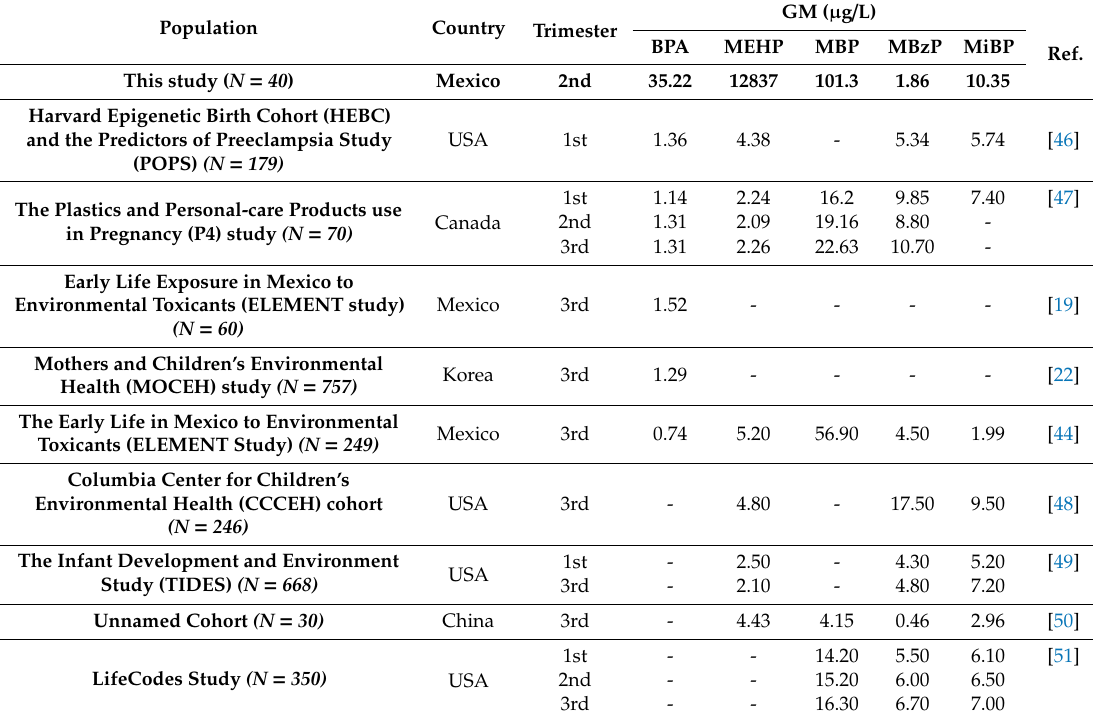
Table 5. Comparison of the median urinary concentrations of total BPA and phthalate metabolites in studies of pregnant women.